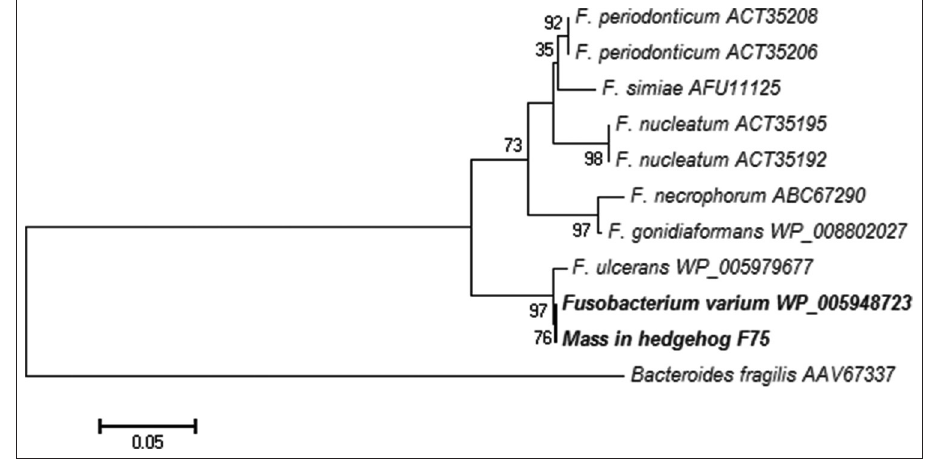
Figure-2: Maximum likelihood tree of the rpoB protein (RNA polymerase beta-subunit) sequences from Fusobacterium spp. (GenBank accession number; MG917664). Percentage bootstrap support from 1000 pseudoreplicates is indicated to the left of the supported